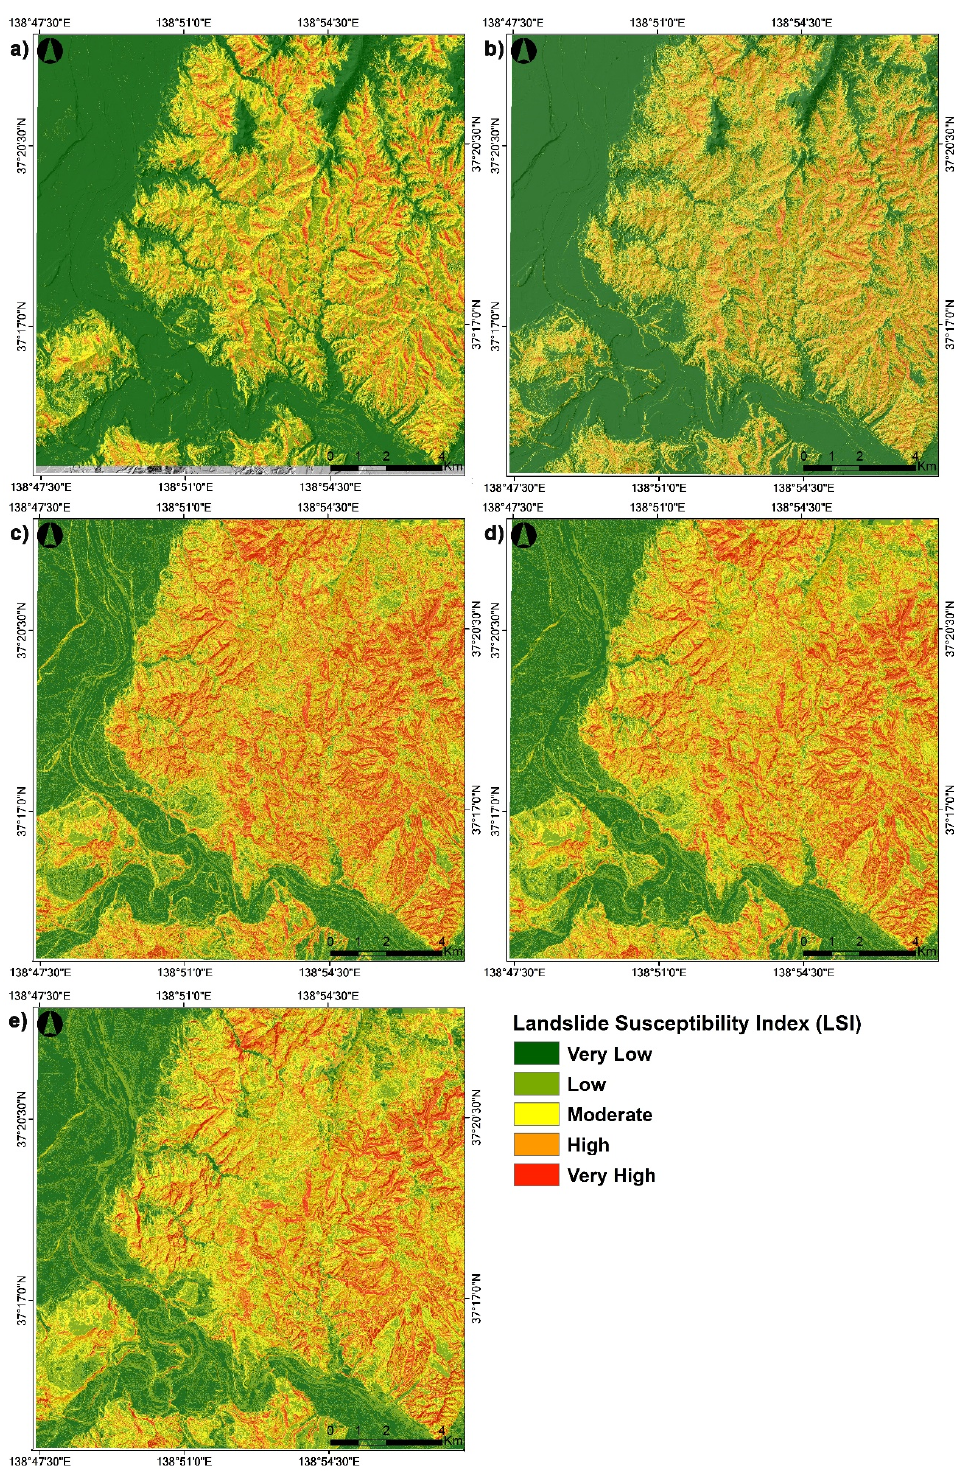
Figure 9. LSM maps produced by ( a ) PLFR, ( b ) InV, ( c ) CF, ( d ) ANN and ( e ) S VM models, respectively.